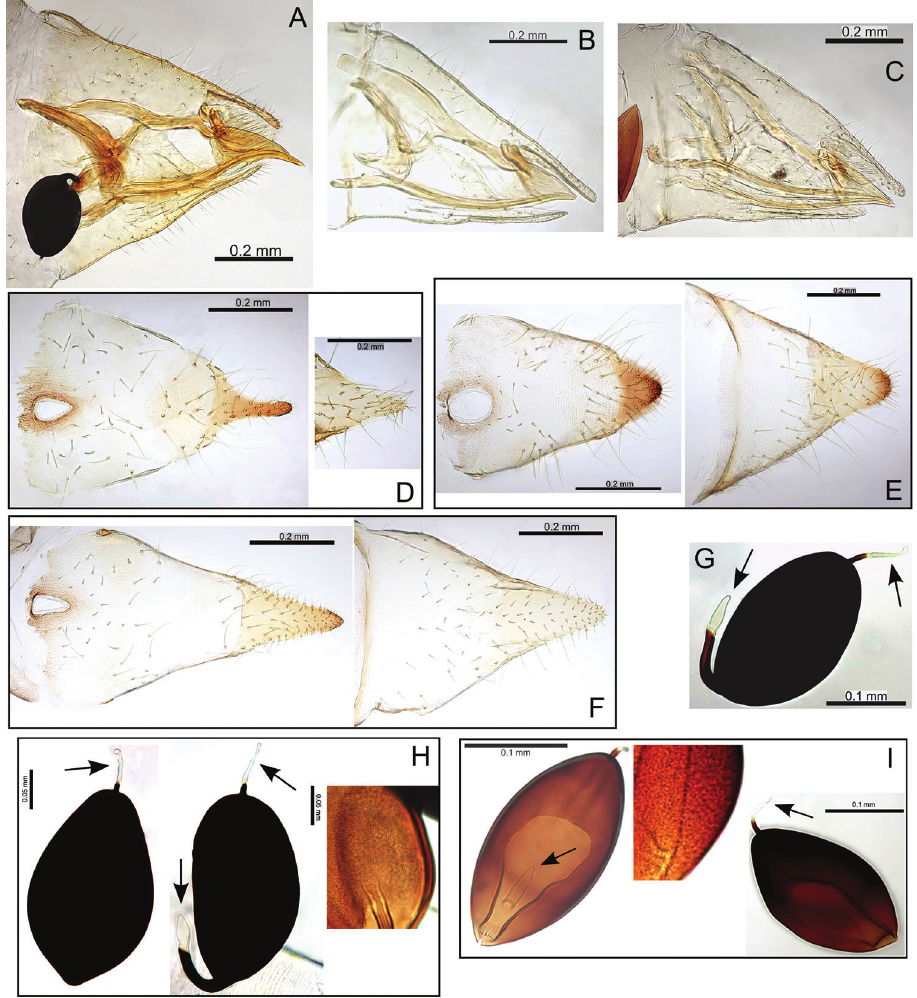
Figure 33. Pariaconus oahuensis sp. n. (females) A, B, C terminalia: A form oahuensis B form tenuis C form latus D, E, F proctiger (dorsal view) and subgenital plate (ventral view) D form tenuis (subgenital plate apex only) E form oahuensis F form latus G, H, I eggs (pedicel and tail indicated, microsculpturing detailed): G form tenuis H form oahuensis I form latus